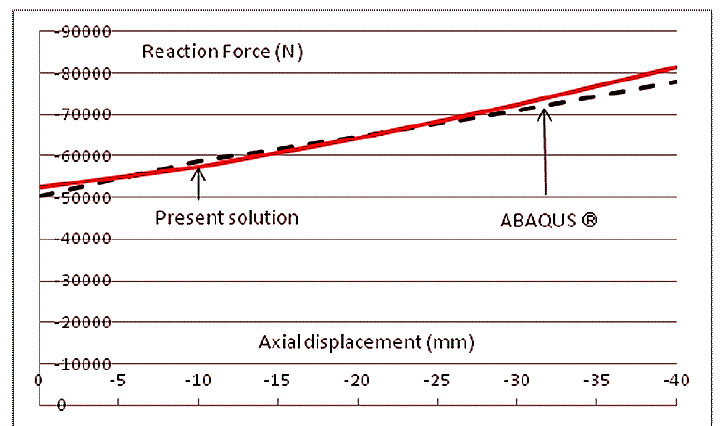
Figure 12. Spring response from prescribed axial displacements with the presented method and ABAQUS ® (Axisymmetric shell elements with ABAQUS ® , with geometry similar to the previous example but initial pressure = 4 bar).